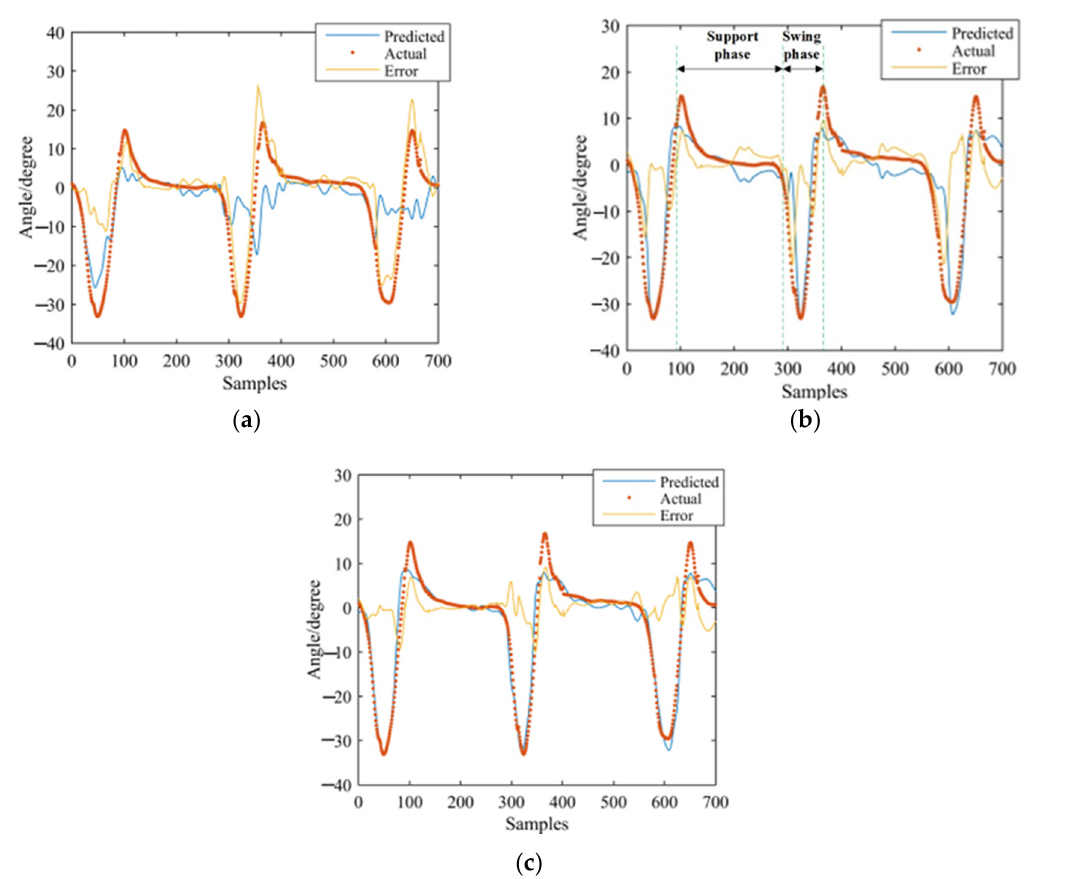
Figure 15. Prediction results of ankle-joint angle in the going upstairs process. ( a ) Results of IN1; ( b ) Results of IN2; ( c ) Results of IN3.